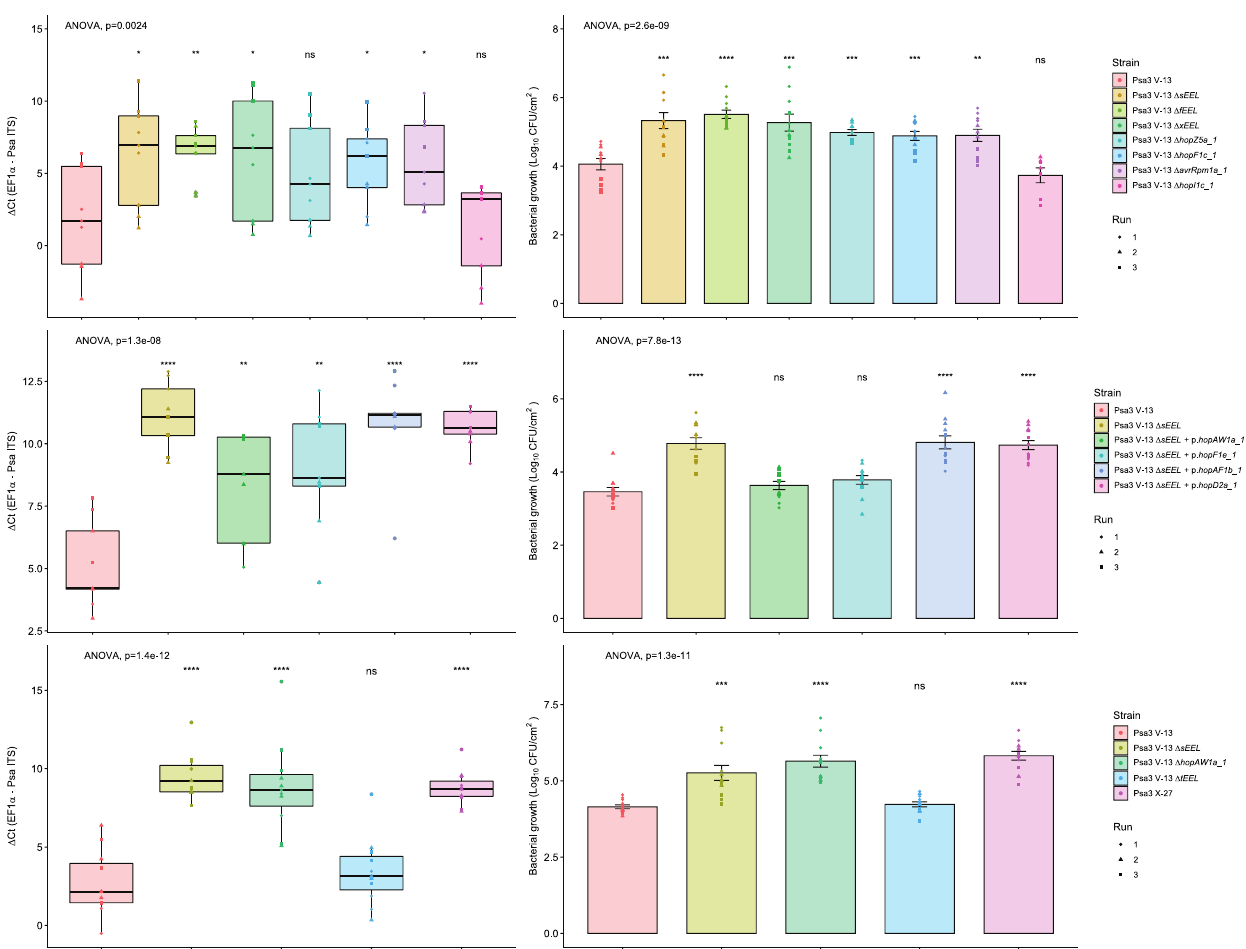
Fig 4. Pathogenicity assay of Psa3 V-13 effector knockout strains and complementation confirming four effectors’ recognition in Actinidia arguta . A . arguta AA07_03 kiwifruit plantlets were flood-inoculated at approximately 10 6 cfu/mL. Bacterial pathogenicity was quantified relative to Psa3 V-13 using the Δ Ct analysis method and box and whisker plots, with black bars representing the median values and whiskers representing the 1.5 inter-quartile range in (A) , (C) , or (E) , or plate count quantification with bar height representing the mean log 10 cfu/cm 2 and error bars representing the standard error of the mean (SEM) in (B) , (C) , or (F), for four pseudobiological replicates, per strain, per experimental run. Bacterial growth was quantified 12 days post-inoculation for selected knockout strains (A) and (B), the plasmid-complemented Δ sEEL strains (C) and (D), or the Δ tEEL and Δ hopAW1a strains (E) and (F). Asterisks indicate the statistically significant difference of Student’s t -test between the indicated strain and wild-type Psa3 V-13, where p � .05 ( � ), p � .01 ( �� ), p � .001 ( ��� ), p � 0.0001 ( ���� ), and p > .05 (ns; not significant). This experiment was separately conducted three times (biological replicates) with three batches of independently grown plants and data were stacked to generate the box plots and bar graphs shown.